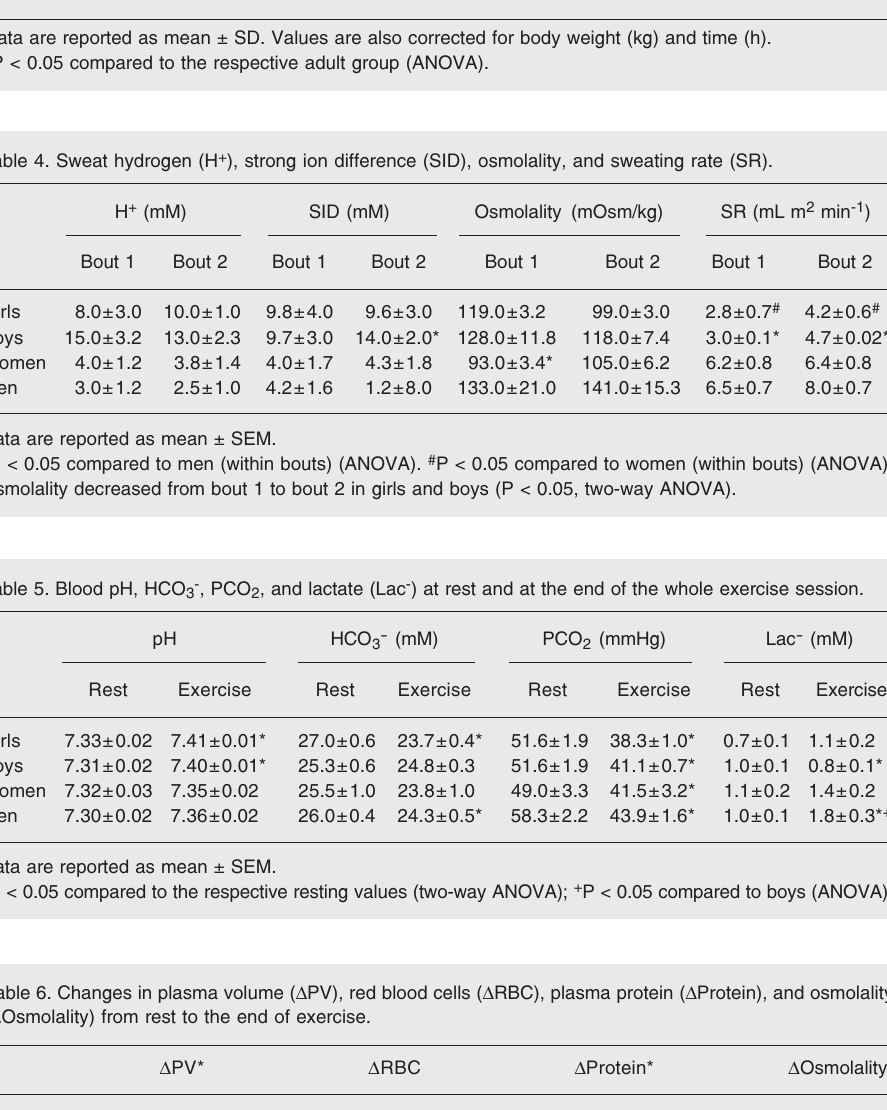
Data are reported as mean ± SD. Values are also corrected for body weight (kg) and time (h).